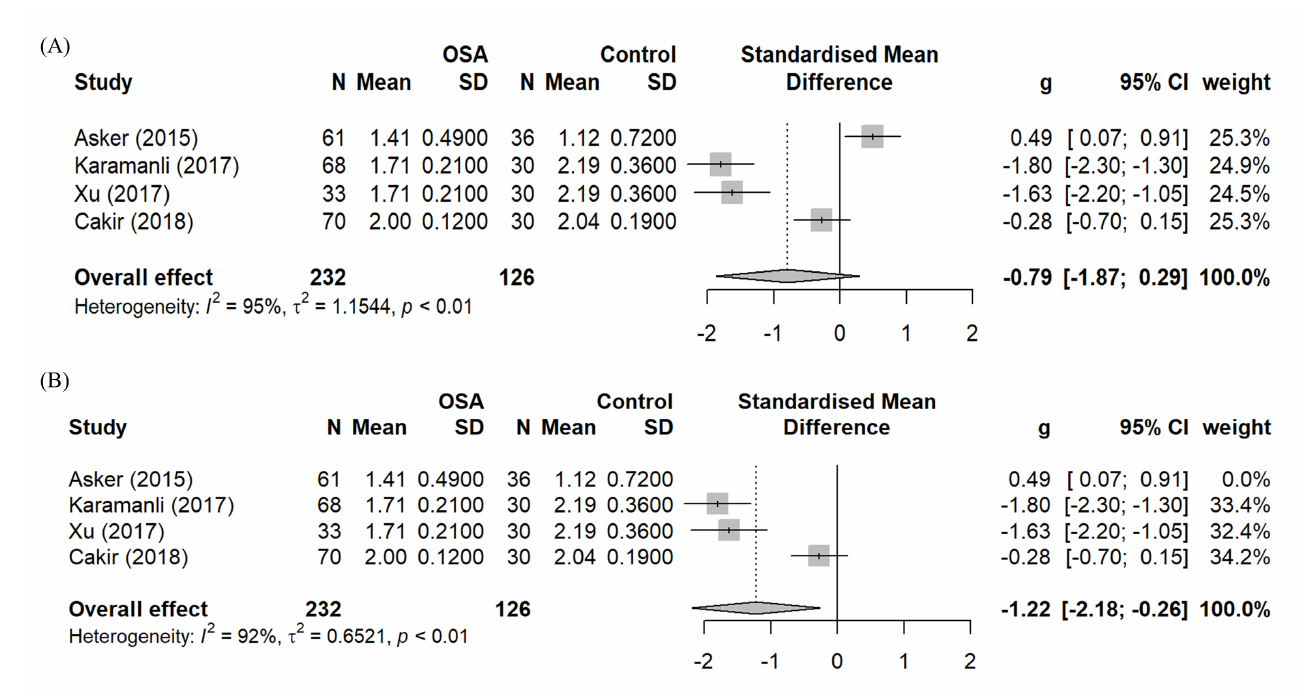
Figure 2. Forest plots–Meta-analyses of the standardised mean difference of the effects of OSA on serum Mg based on: (A) Four studies that compared the serum Mg levels of OSA patients to healthy controls [21,23–25]; (B) After exclusion of Asker et al.